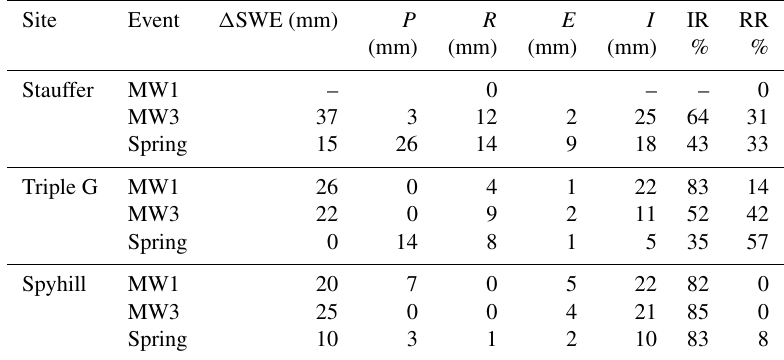
Table 3. Water balance components for individual snowmelt events at the study sites. Site